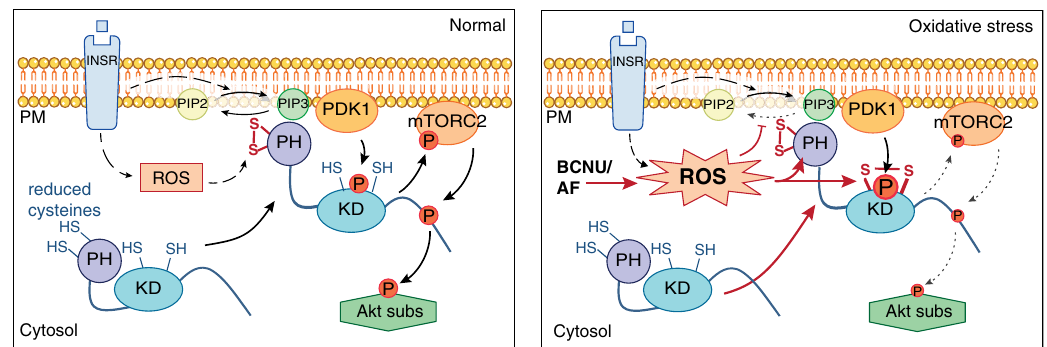
Fig. 8 Model depicting redox-dependent mechanism for Akt activation. Insulin stimulation promotes an increase in cytosolic ROS (possibly via NOX4). This oxidizes the PH domain cysteines and augments the recruitment of Akt to the PM. Under condition of oxidative stress, the PH domain gets hyper-oxidized, which in concert with other ROS effects, such as the inhibition of PTEN, enhances Akt recruitment and leads to hyperphosphorylation of T308 in Akt. Under these conditions, an inhibitory disulphide (Cys297 – Cys311) also forms in the kinase domain. This reduces Akt activity resulting in impaired substrate (Akt subs) phosphorylation. Dotted lines denote multiple steps between nodes. Solid lines denote a For total proteomic analysis, 3T3-L1 fi broblasts were triple SILAC labelled 70 . All studies used adipocytes between 8 and 12 days after differentiation. Cells were treated with 100 μ M BCNU or 1 μ M AF for the indicated times. L6 rat myoblasts (ATCC ® CRL-1458 ™ ) were grown in α -Minimum essential